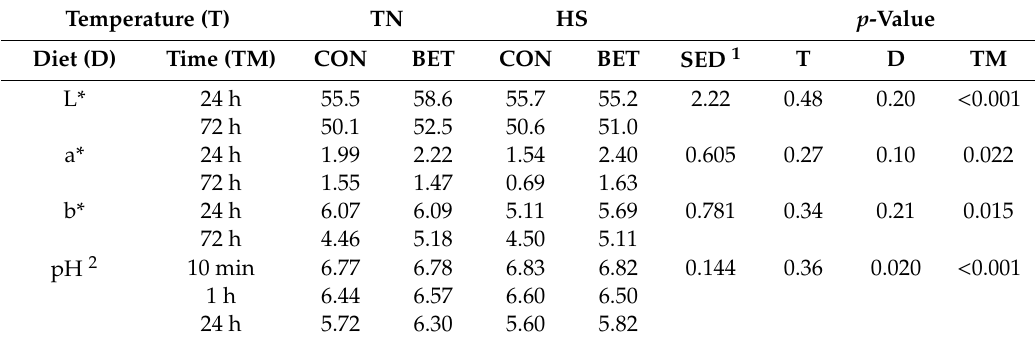
Table 5. E ff ect of betaine (BET) and time post-slaughter on chicken breast ( pectoralis major ) colour and pH after being housed under thermoneutral (TN) and heat stress (HS)